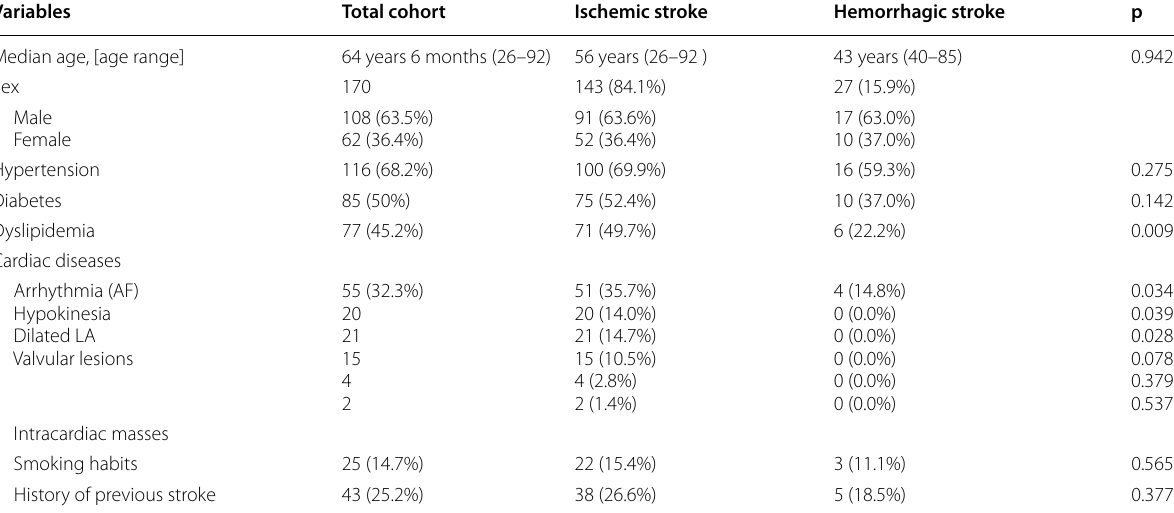
By Mann Whitney test and Chi square test, *p value was significant